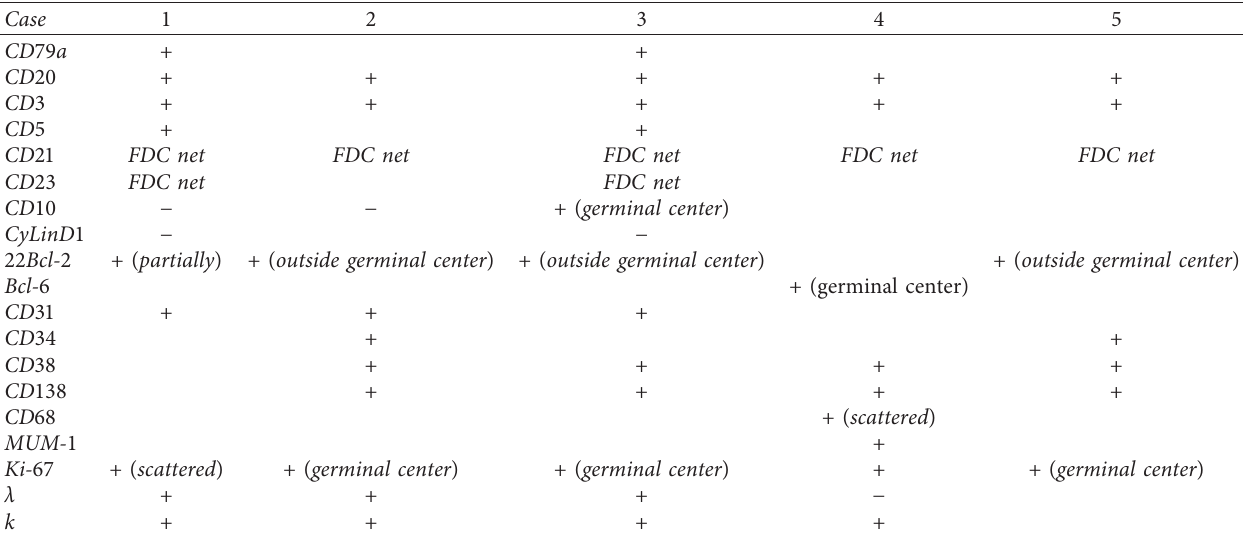
Table 2: Pathological findings of 5 patients with CD of the lacrimal gland.